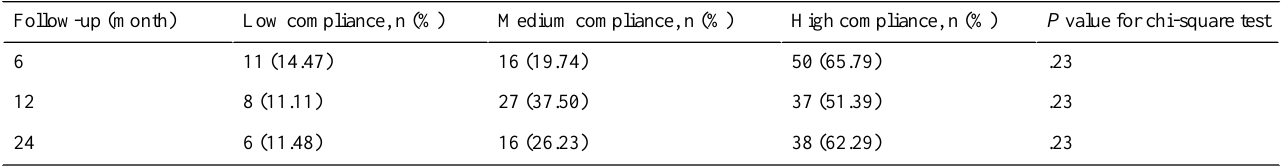
Table 2. Compliance status in different